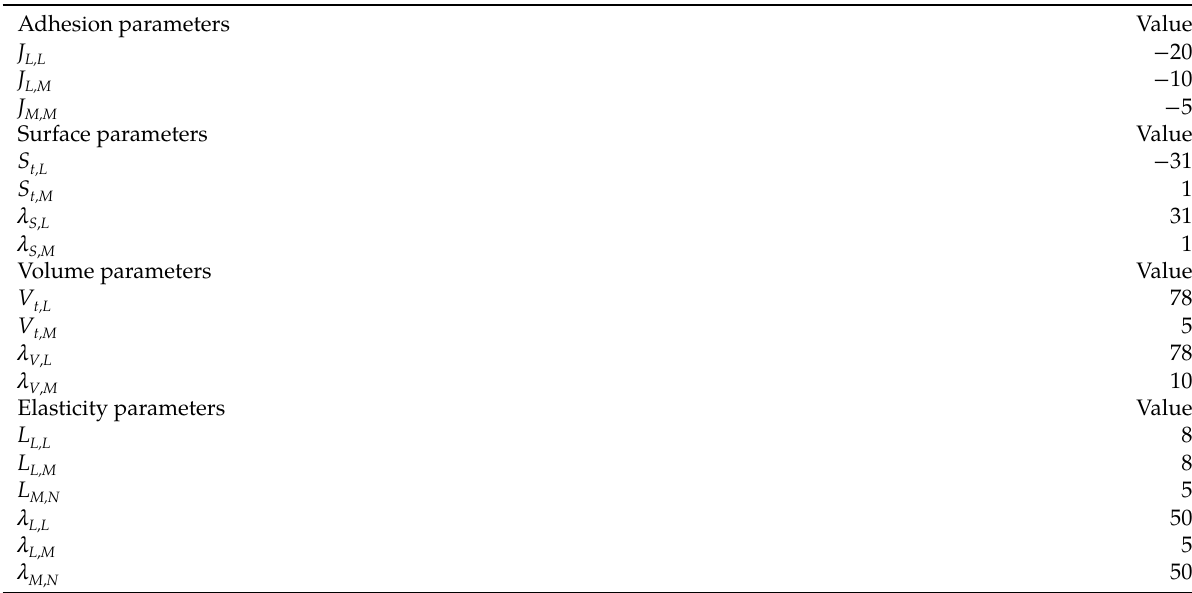
Table 1: Parameters for